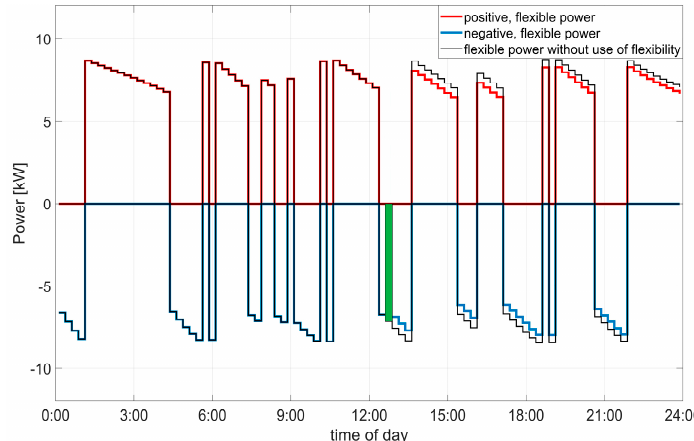
Figure 4. Available, flexible power without using flexibility at 12:30 (thin line) compared to the one after using flexibility.